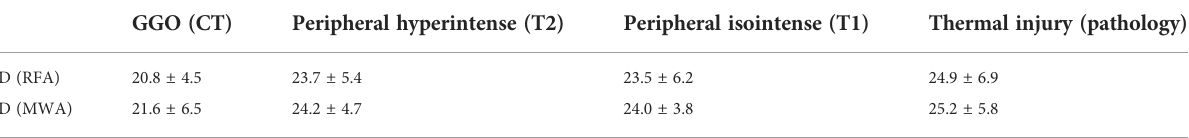
TABLE 4 Comparison of MD of GGO around tumor on CT, peripheral hyperintense zone on T2WI, peripheral isointense on T1WI, and thermal injury on pathology post-ablation